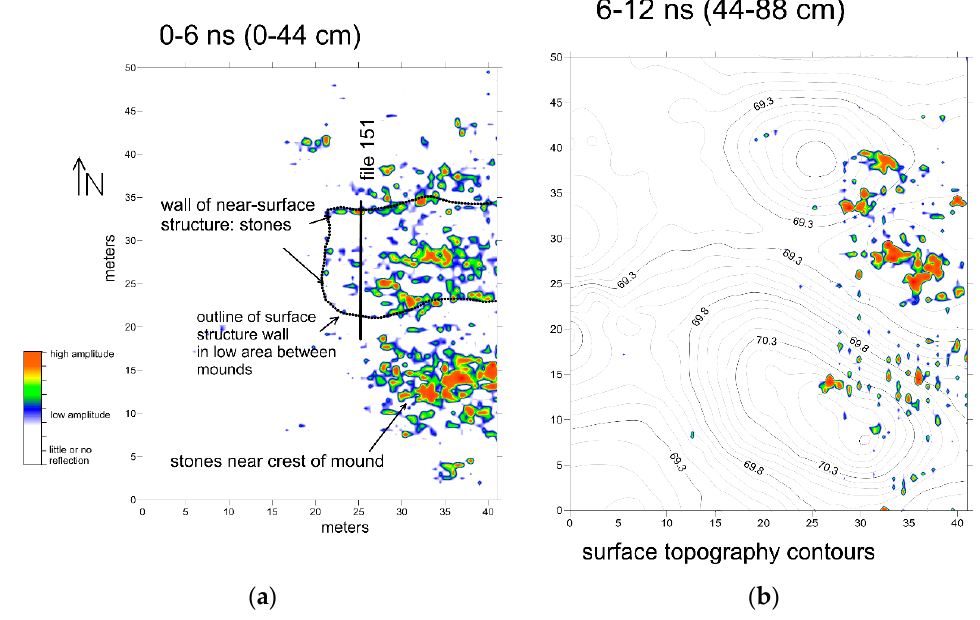
Figure 3. ( a ) Amplitude slice-maps of the first two slices of the ground, showing the outline of the near-surface structure and other stones near the southern mound crest. ( b ) The surface topography contour map is overlaid on the amplitude map on the right.